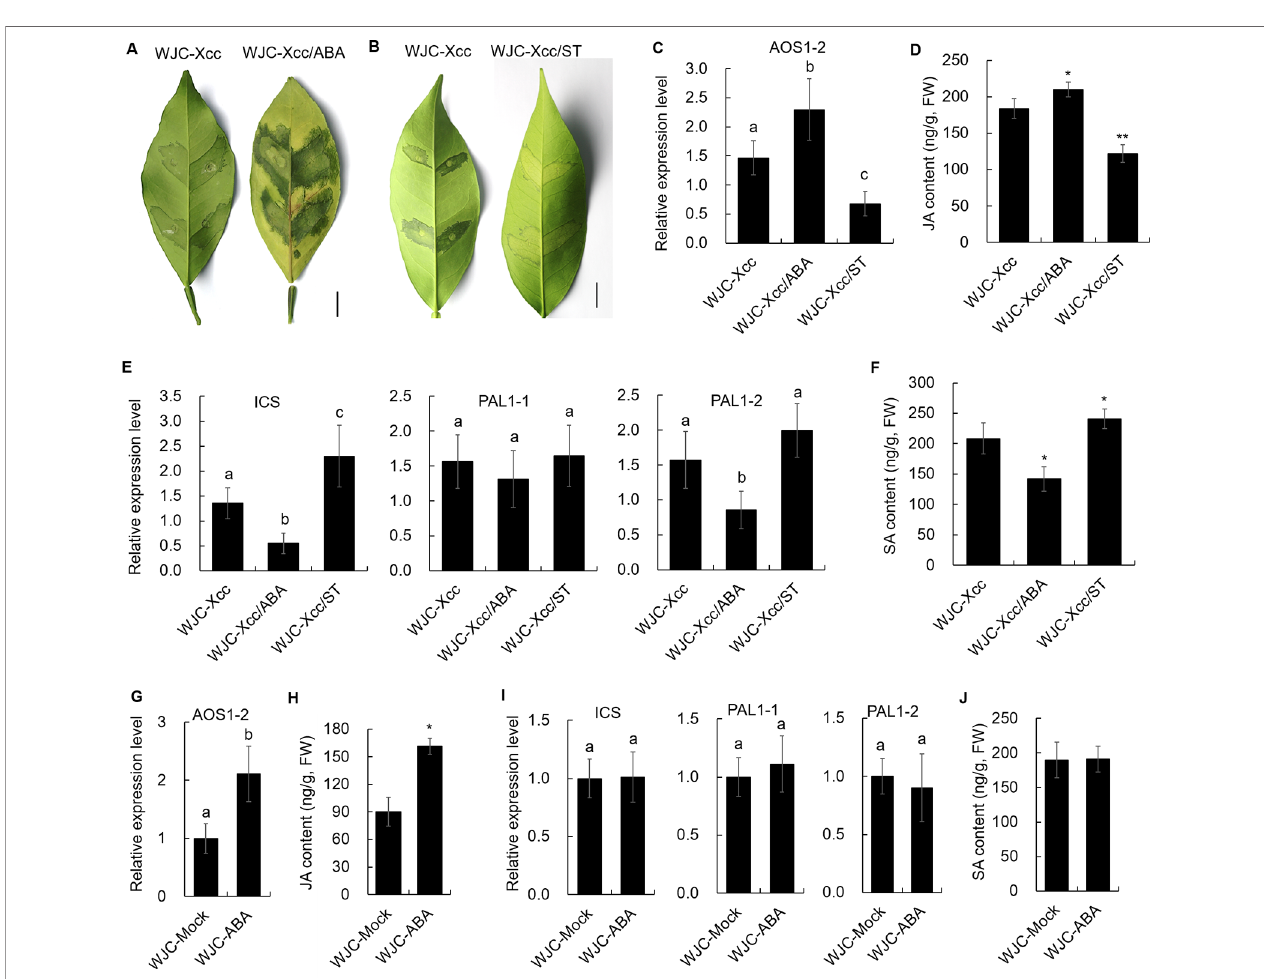
FIGURE 8 | Effects of ABA and its synthesis inhibitor on canker resistance and JA and SA synthesis in Wanjincheng orange. (A) Effects of exogenous ABA on the canker resistance of Wanjincheng orange leaves infected with Xcc. (B) Effects of ABA synthesis inhibitor ST on the canker resistance of Wanjincheng orange leaves infected with Xcc. Photographs were taken at 6 days after inoculation. Scale bars = 1 cm. (C) Relative expression of the AOS1-2 gene in Wanjincheng orange leaves induced by exogenous ABA after infection with Xcc. (D) JA content in citrus leaves treated with ABA after infection with Xcc. (E) Relative expression levels of genes involved in SA synthesis in Wanjincheng orange leaves induced by exogenous ABA after infection with Xcc. (F) SA content in citrus leaves treated with ABA after infection with Xcc. (G) Relative expression level of the AOS1-2 gene in Wanjincheng orange after the ABA treatment. (H) JA content in Wanjincheng orange leaves after the ABA treatment. (I) Relative expression levels of genes involved in SA synthesis in Wanjincheng orange leaves induced by exogenous ABA. (J) SA content in citrus leaves treated with ABA. All the samples were detected at 3 days after treatment. Leaves treated with Xcc (C – F) or water (G – J) were used as control. Error bars of content determinations indicate the SDs of three biological repeats. Statistical signi fi cance related to the control was determined by two-tailed Student ’ s t - test (*, P < 0.05; **, P < 0.01). Error bars of expression levels represent the SDs of three biological replicates. Different letters above bars represent signi fi cant differences from the control based on Duncan ’ s multiple range test ( P < 0.05). WJC, Wanjincheng orange; ABA, abscisic acid; ST, sodium tungstate; AOS, 13-allene oxide synthase; JA, jasmonic acid; ICS, isochorismate synthase; PAL, phenylalanine ammonia lyase; SA, salicylic acid; FW, fresh